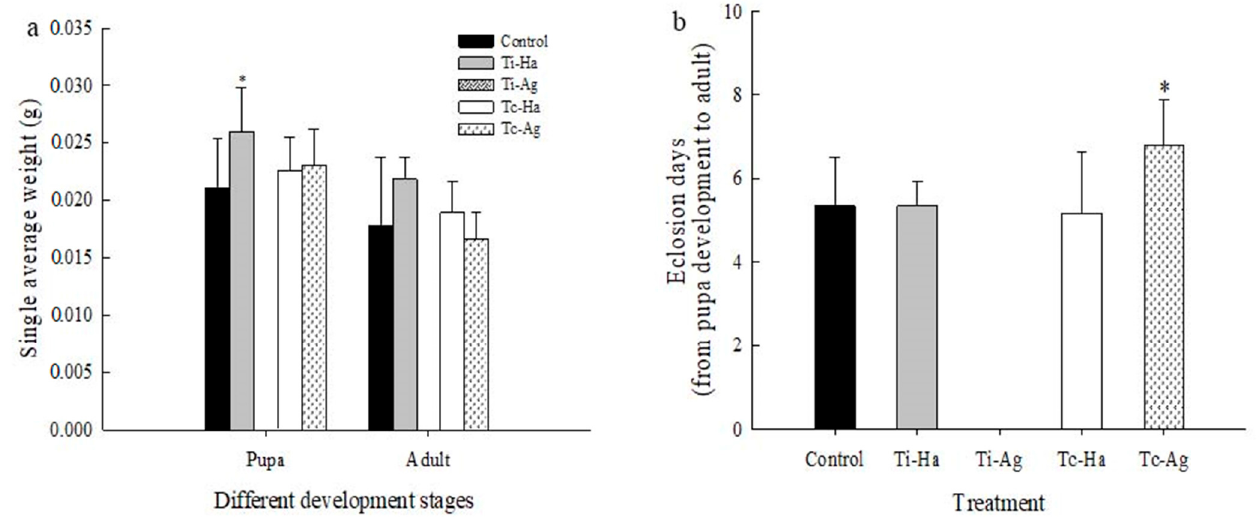
Figure 2. The food consumption rates of ladybirds in four treatments and control. * and ** in the column respectively represent significant and extremely significant differences from the control group at 0.05 and 0.01 (one-way ANOVA), respectively.